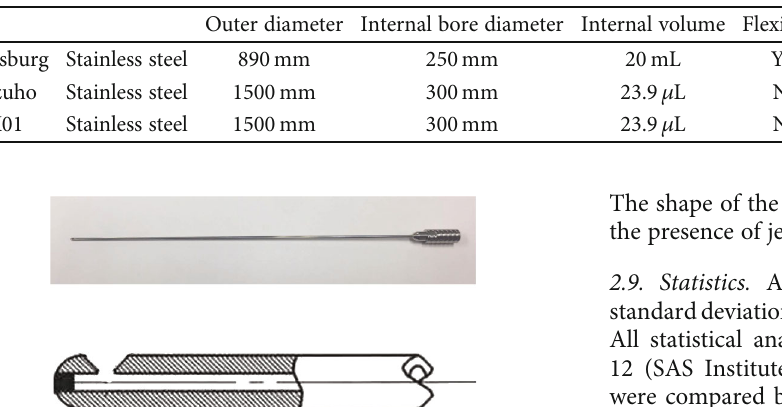
Table 1: Basic characteristics of the cannulas.